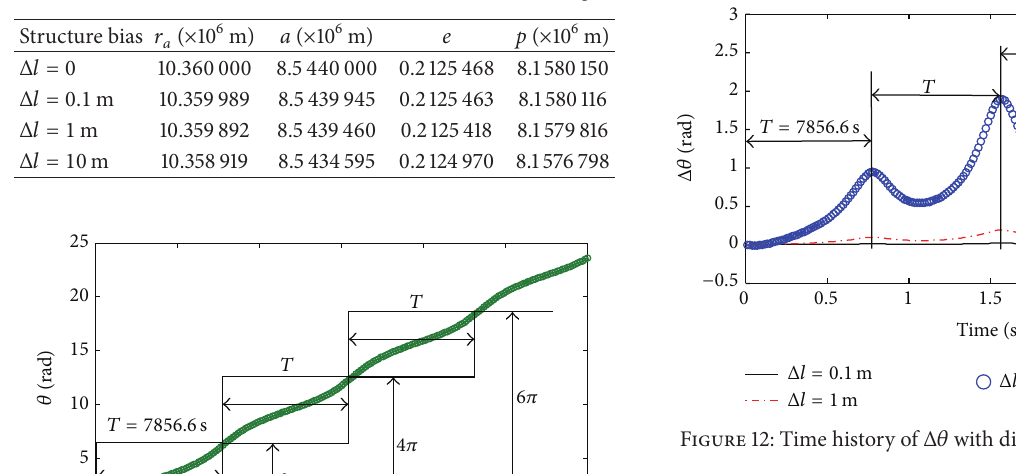
Table 3: The relative orbital errors with difference in tethers’ length.